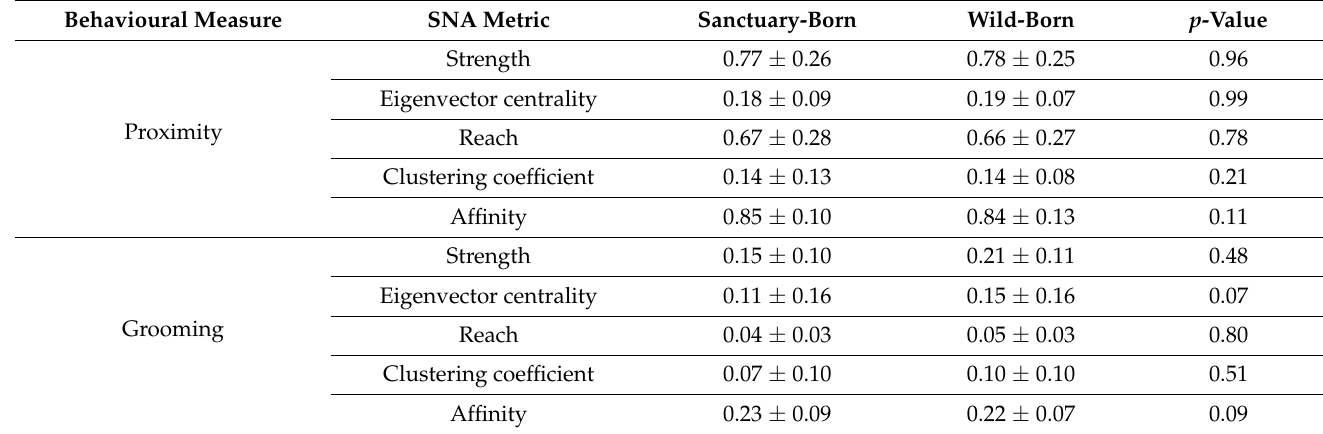
Table 1. Social network metrics (mean ± SD) including significance testing ( p -value) for the (difference between) sanctuary-born and wild-born chimpanzees at